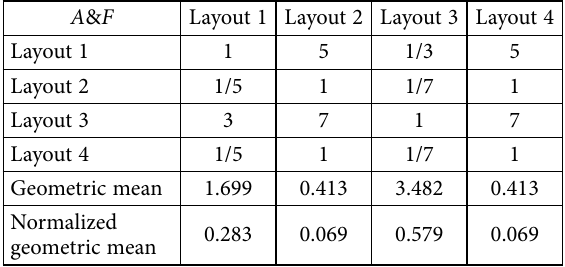
Table 7. The comparison matrix of the layouts for accessibility and flexibility (A&F)